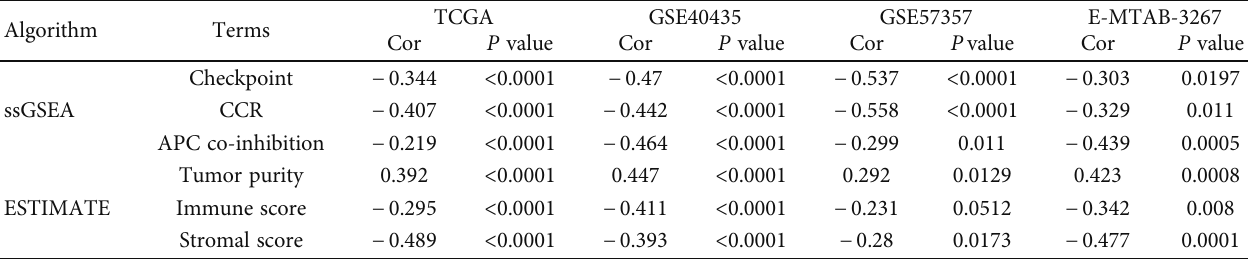
(Figure 7(a)). Then, the e ff ect of changes in FXYD2 overex- pression on the proliferation, colony formation, migration, and invasion of ccRCC cells were determined by CCK-8 assay, colony formation assay, cell migration, and invasion assays. The results showed that FXYD2 signi fi cantly inhibit (Figure 7(b)), colony formation (Figure 7(c)), migration (Figure 7(d)), and invasion (Figure 7(e)) in the overexpression 786-O and OSRC2 cell lines, respectively. Moreover, knockdown of FXYD2 by siRNA in above overexpression 786-O and OSRC2 cell lines showed the resecure phenomenon compared with the con- trol groups (Figure S5).